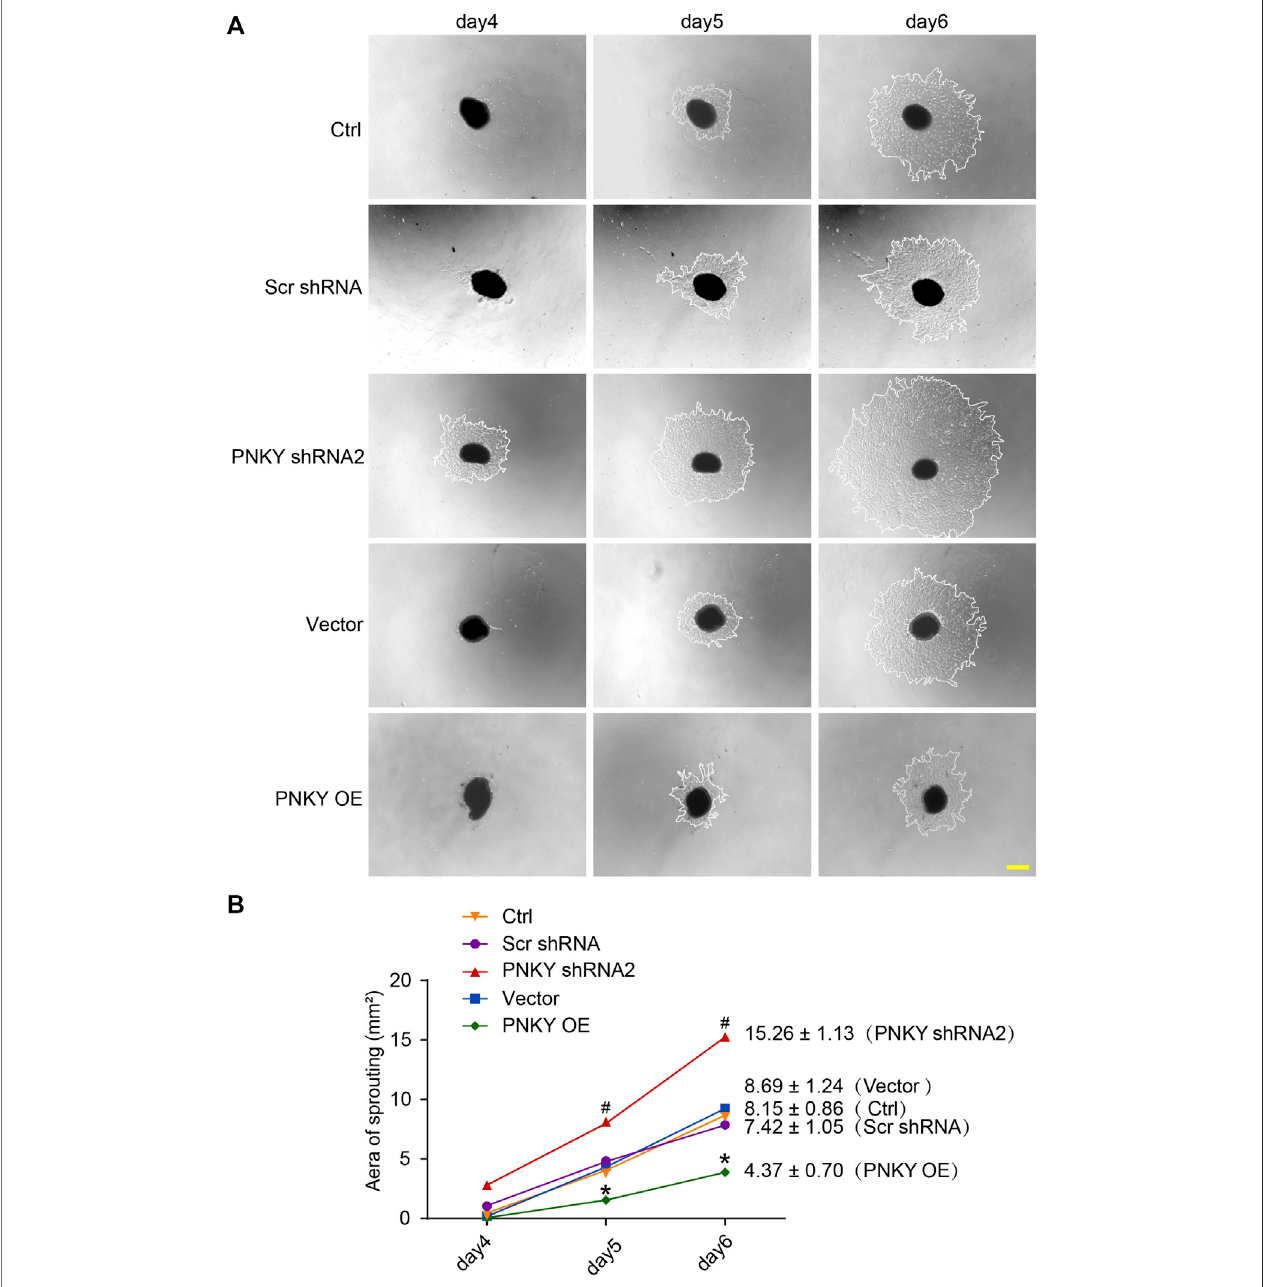
FIGURE3| LncRNA PNKY regulateschoroidalsprouting exvivo .Eight-week-oldC57BL/6 mice received anintravitreal injection ofscrambled (Scr)shRNA, PNKY shRNA2,vehicle(Vector),PNKYoverexpressionvector(PNKYOE),orleftuntreated(Ctrl).Atday14,themouseRPE/choroidcomplexesweredissected.Theperipheral regionswerecutinto1 mm×1 mmpiecesandseededintothe24-wellplatestoassessthepotentialangiogeniccapacityofchoroidalexplantsineachgroupofmice. (A) Exampleimagesofthechoroidalsproutingareasatspeci fi edtimepointsweredemonstrated.Scalebar,500 μ m. (B) Quanti fi cationoftheareasoftheCNVsprouts was shown ( n = 5, * p < 0.05 versus Scr shRNA, # p < 0.05 versus Vector, Kruskal – Wallis ’ test followed by Bonferroni ’ s post hoc test).